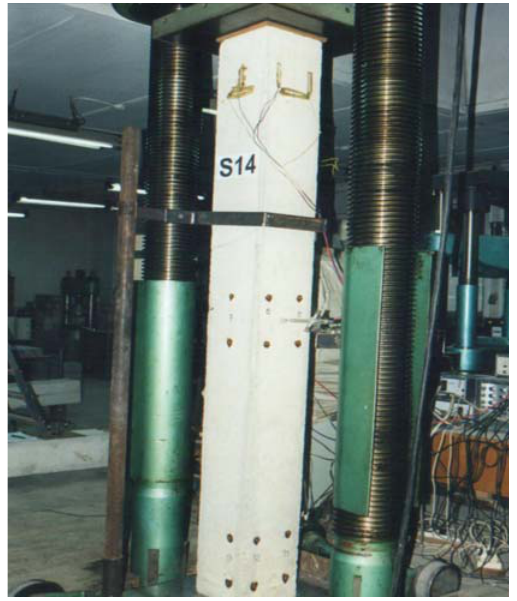
Fig 1 . Testing stand of the columns